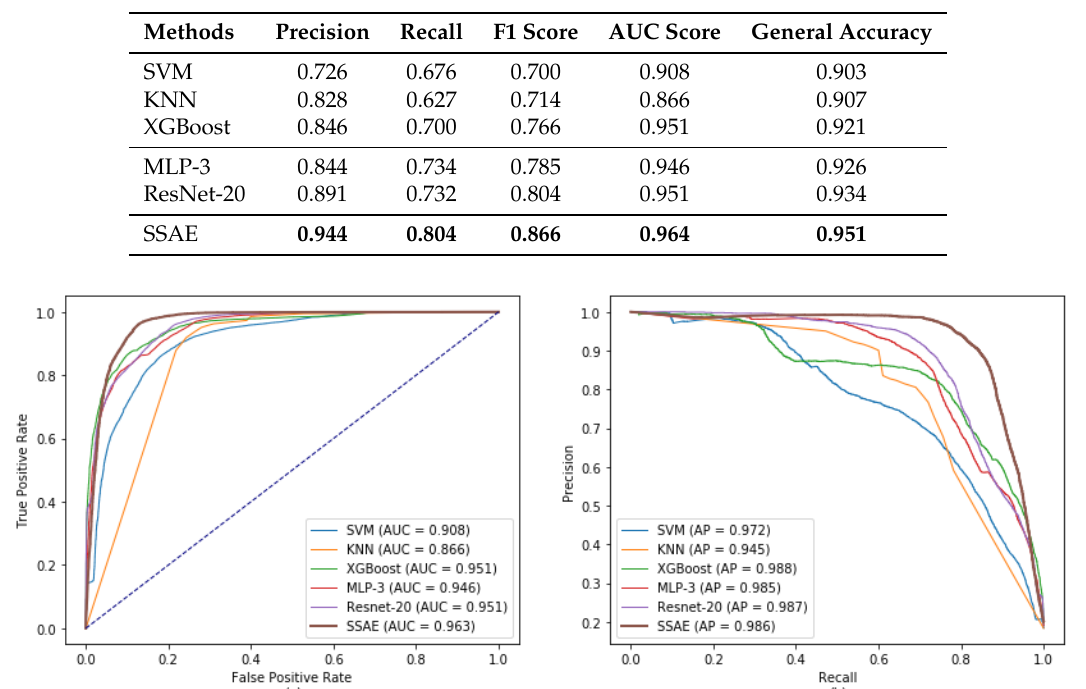
Table 4. NTL detection performance comparison (with knowledge).